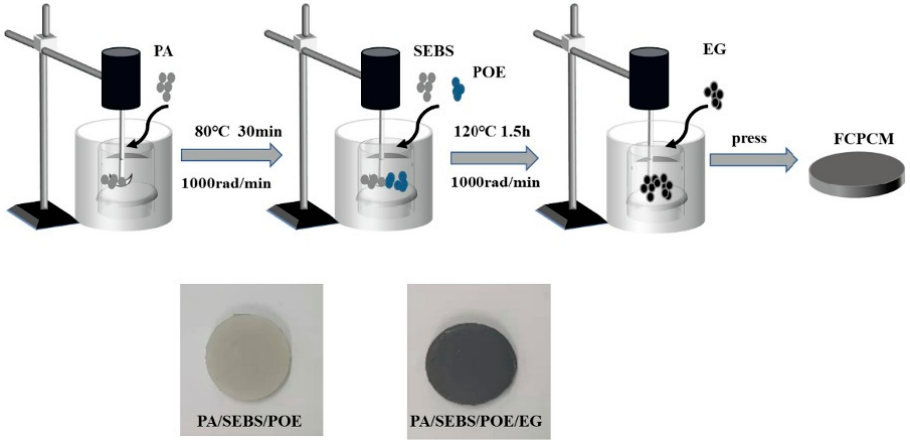
Figure 4. The preparation procedure of the Flexible Composite PCM (FCPCM) [35]. Reproduced with permission from Elsevier.